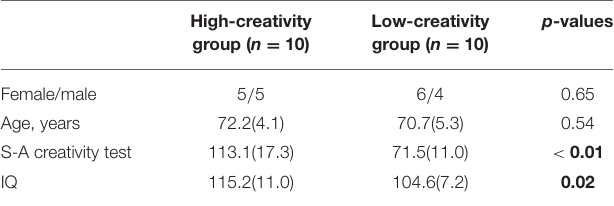
TABLE 1 | Physical characteristics of the high- and low-creativity groups (values are mean